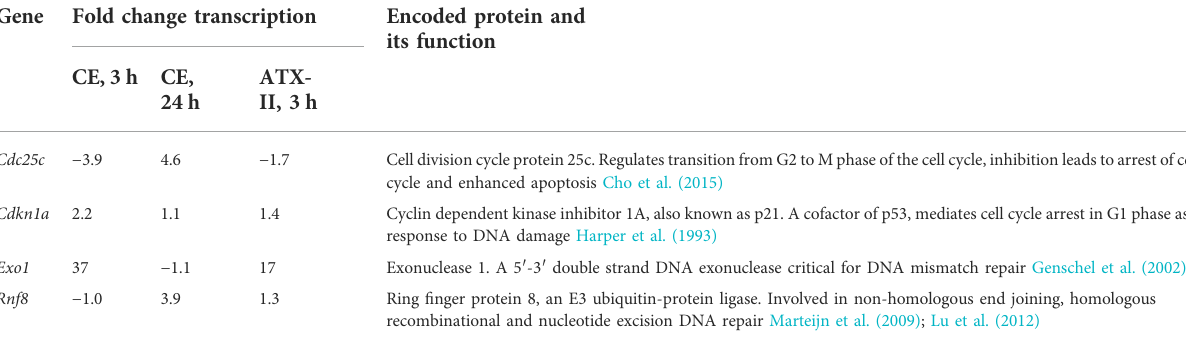
TABLE 1 Changes in gene transcription of selected genes in treated animals (10 rats per group) as determined with the RT2 pro fi ler PCR array PARN- 029Z, DNA damage andrepair (Qiagen) andanalyzed byuploadingthe Ct-values inthe web portalathttp.//www.qiagen.com/geneglobe.Afold- change of 2 was set as the level of signi fi